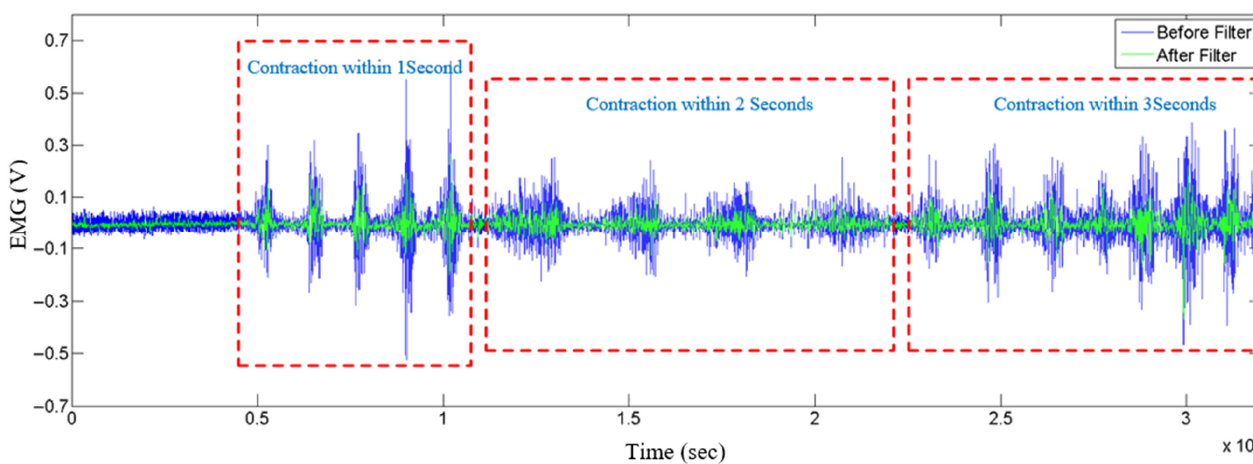
Figure 9. Filter effect on the sEMG raw data.